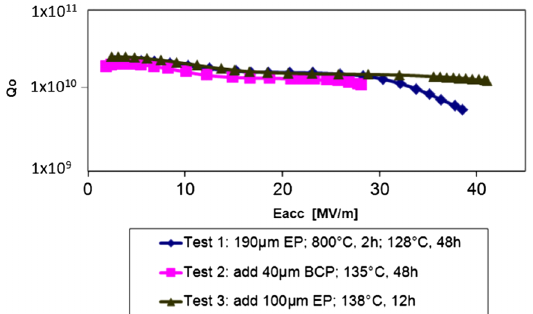
FIG. 11. Unloaded quality factor Q 0 versus accelerating gra- dient Q 0 ð E acc Þ of the LG single cell cavity 1AC4 after EP and BCP treatment.